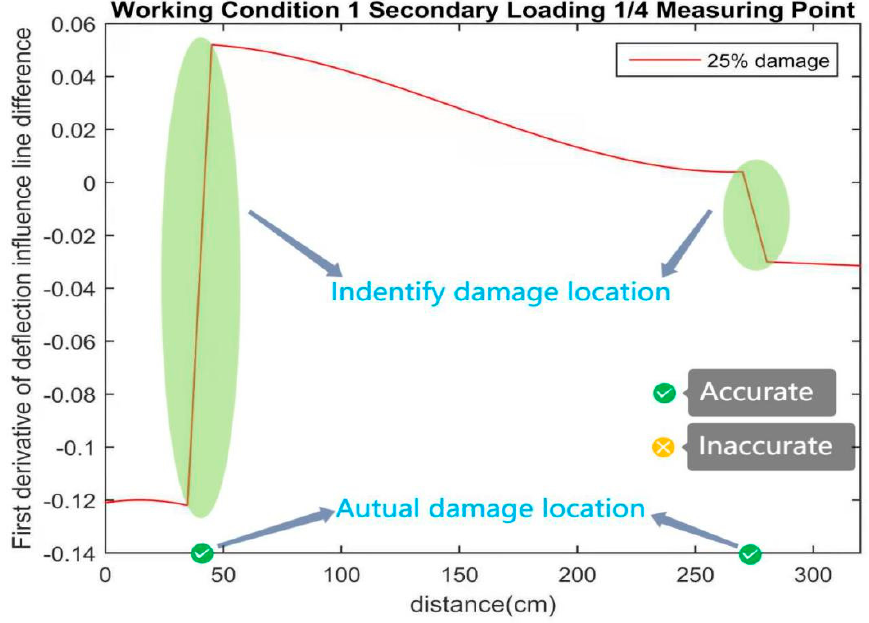
Figure 34. The first-order derivation of deflection influences line difference at 25/100 calculating point of the first span following work condition 4.